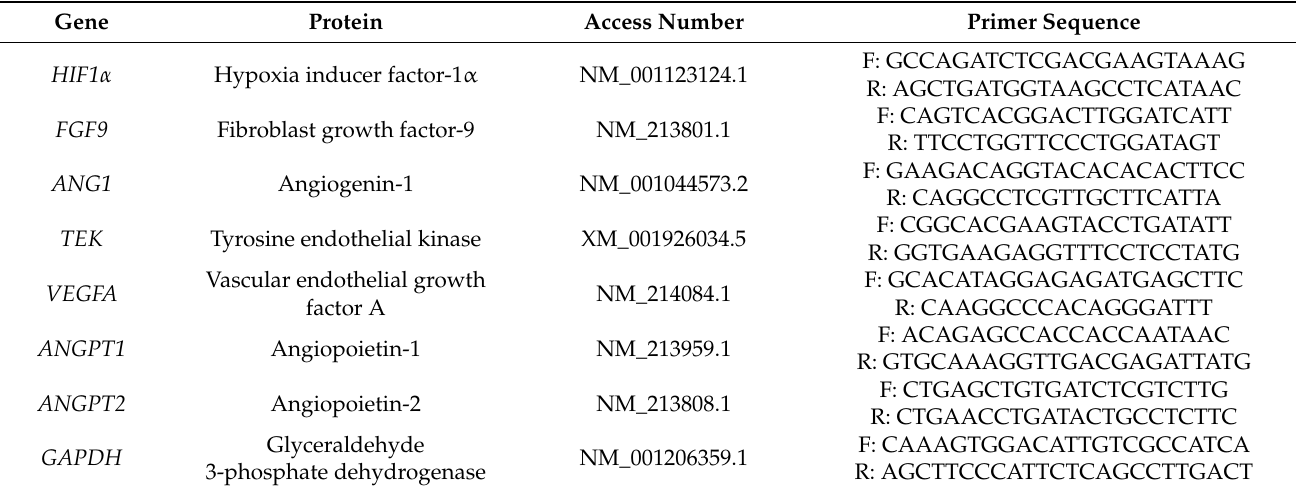
Table 1. Primers used for amplification in real-time PCR